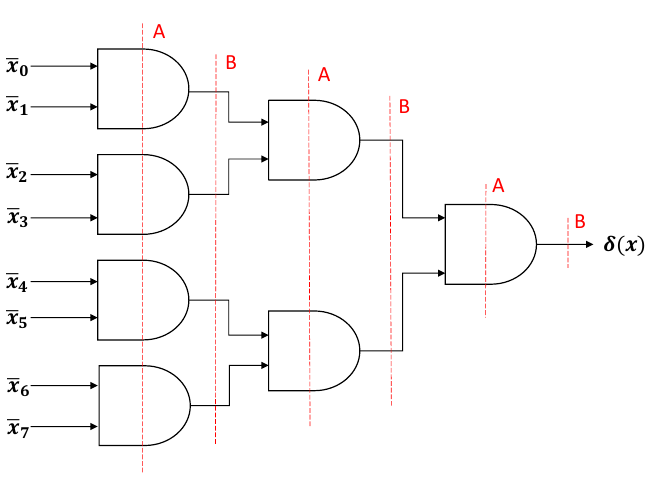
Figure 15: Circuit for the shared Kronecker delta function δ ( x ) for n =